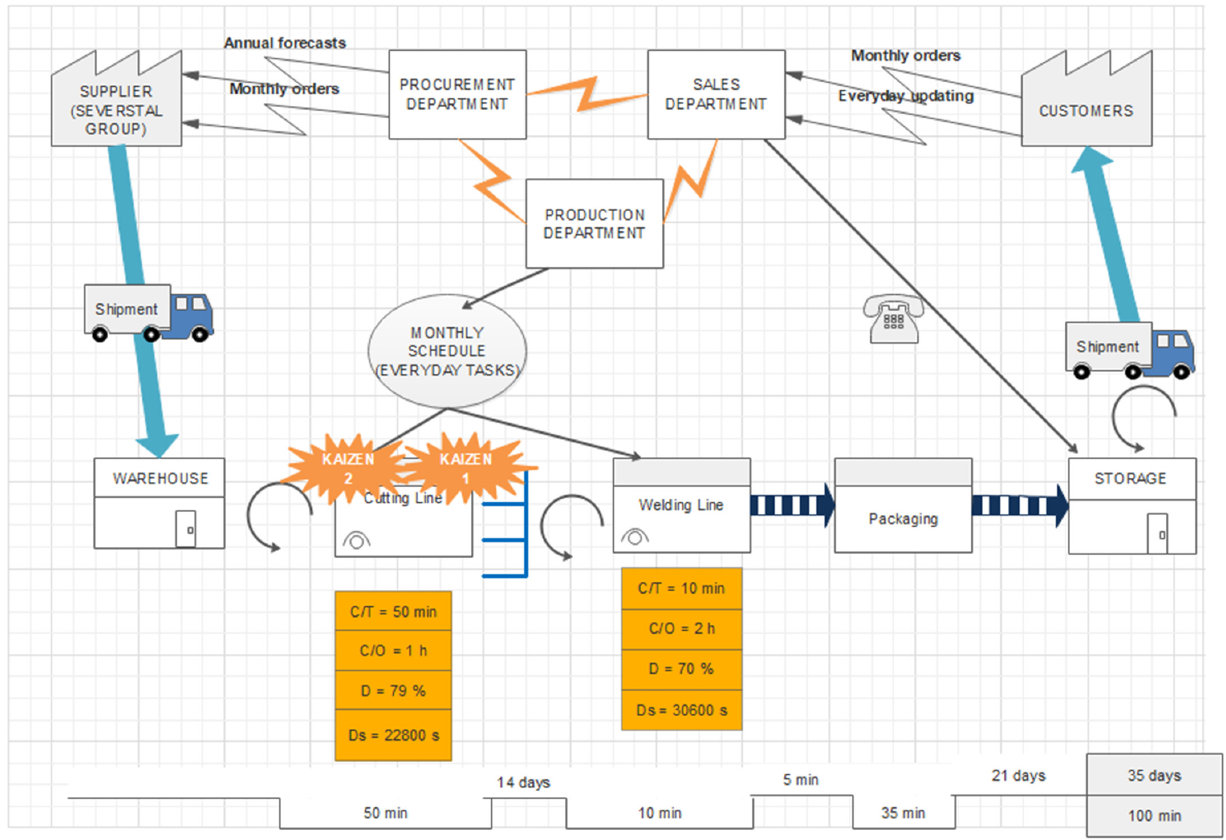
Figure 8. Map of future state.